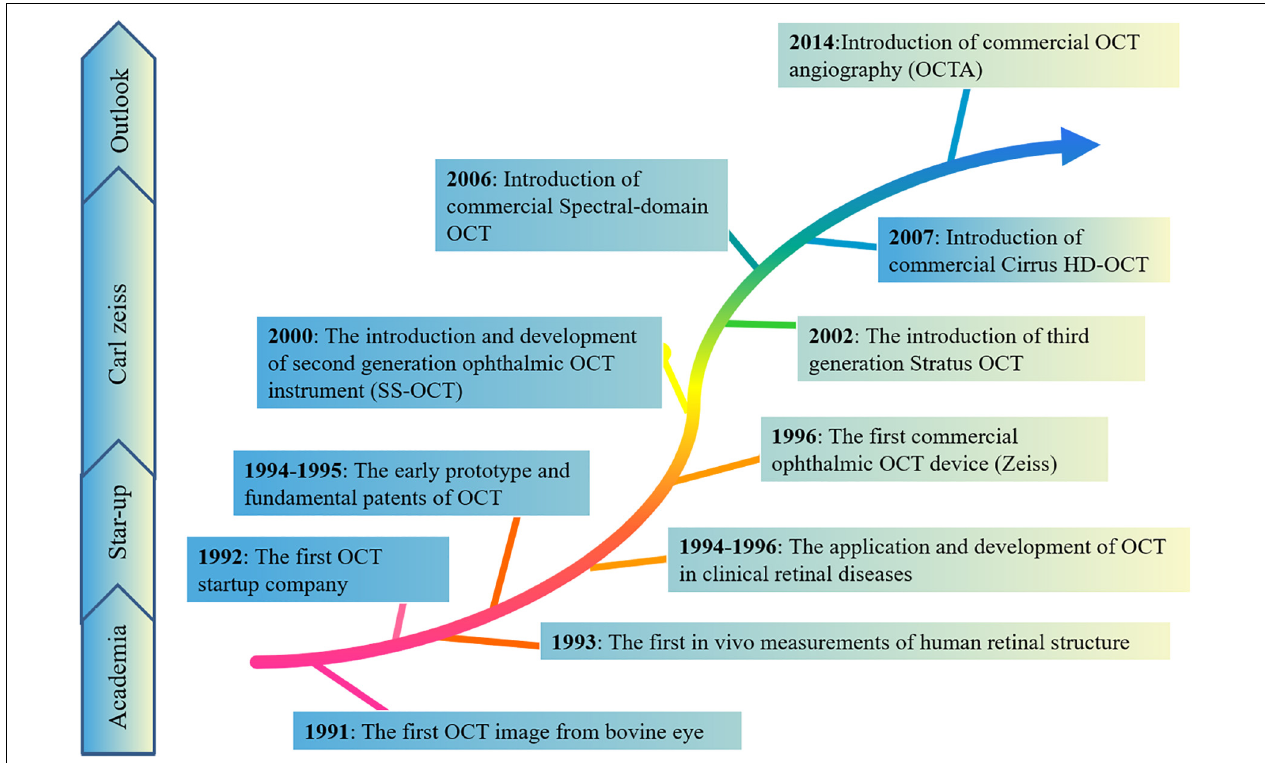
FIGURE 2 | The brief historical timeline marking events elucidating morphological and technologies in the retina. These new, cost-effective, high-resolution imaging tools enabled increases in imaging speeds and quantity, further catering to the clinical needs of diagnosis and therapeutics of diseases, and increasing clinical data demonstrated the important role of OCT in diagnostic and therapeutic applications of many